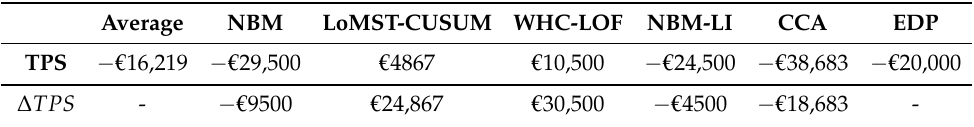
Table 7. Total Prediction Savings (TPS) and improvement over EDP ( ∆ TPS ) for each model for test